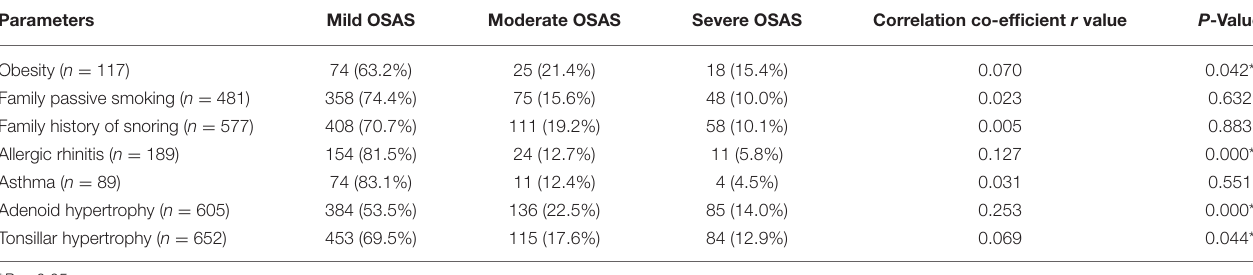
TABLE 4 | Spearman correlation analyses of the relationships between risk factors and the severity of pediatric OSAS. Parameters